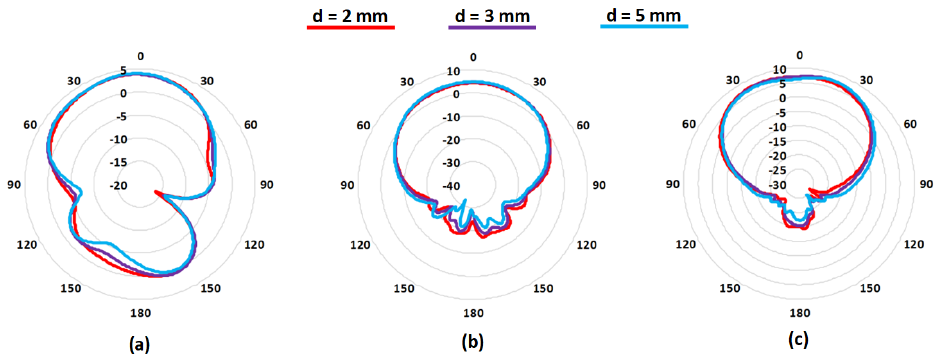
Figure 20. Simulated radiation pattern of the antenna in E-plane for various distances at frequencies of ( a ) 2.45 GHz, ( b ) 5.8 GHz, and ( c ) 8.0 GHz.